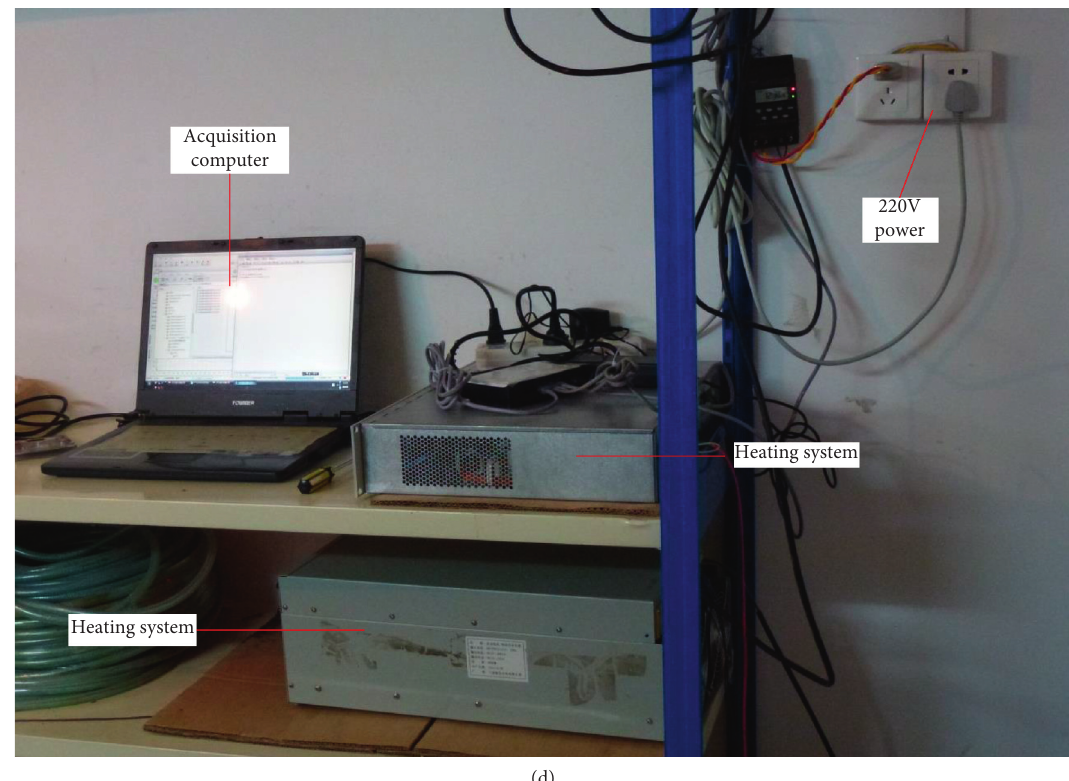
Figure 1: DTS equipment and system composition. (a) Optical fiber temperature acquisition instrument; (b) heating system; (c) distributed fiber optic sensor; (d) measuring